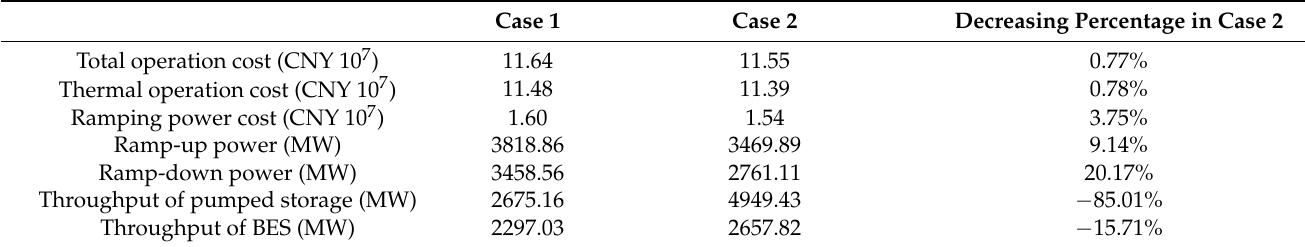
Table 4. Comparison of Case 1 and Case 2